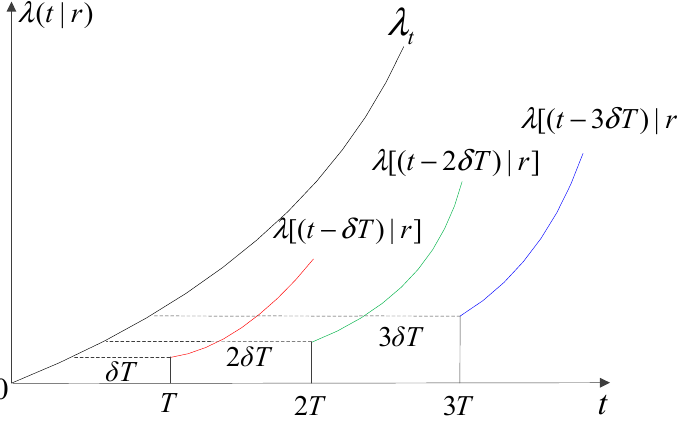
Figure 2. Schematic diagram of the virtual age method.